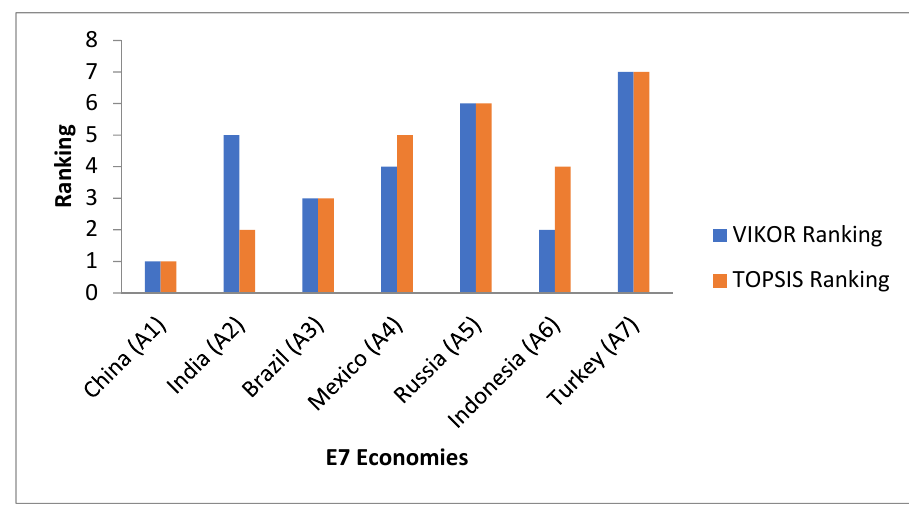
Figure 4. Comparative rankings of the interval type 2 (IT2) fuzzy VIKOR and IT2 TOPSIS.